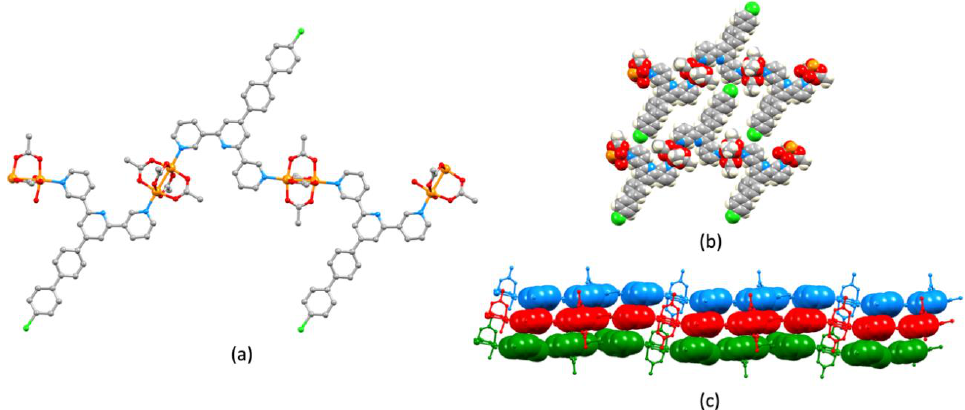
Figure 8. ( a ) Part of one polymer chain in [Cu 2 (μ -OAc) 4 ( 3 )] n , ( b ) interdigitation of chains generates a 2D-sheet, and ( c ) stacking of three adjacent sheets involves both pyridine and biphenyl rings.